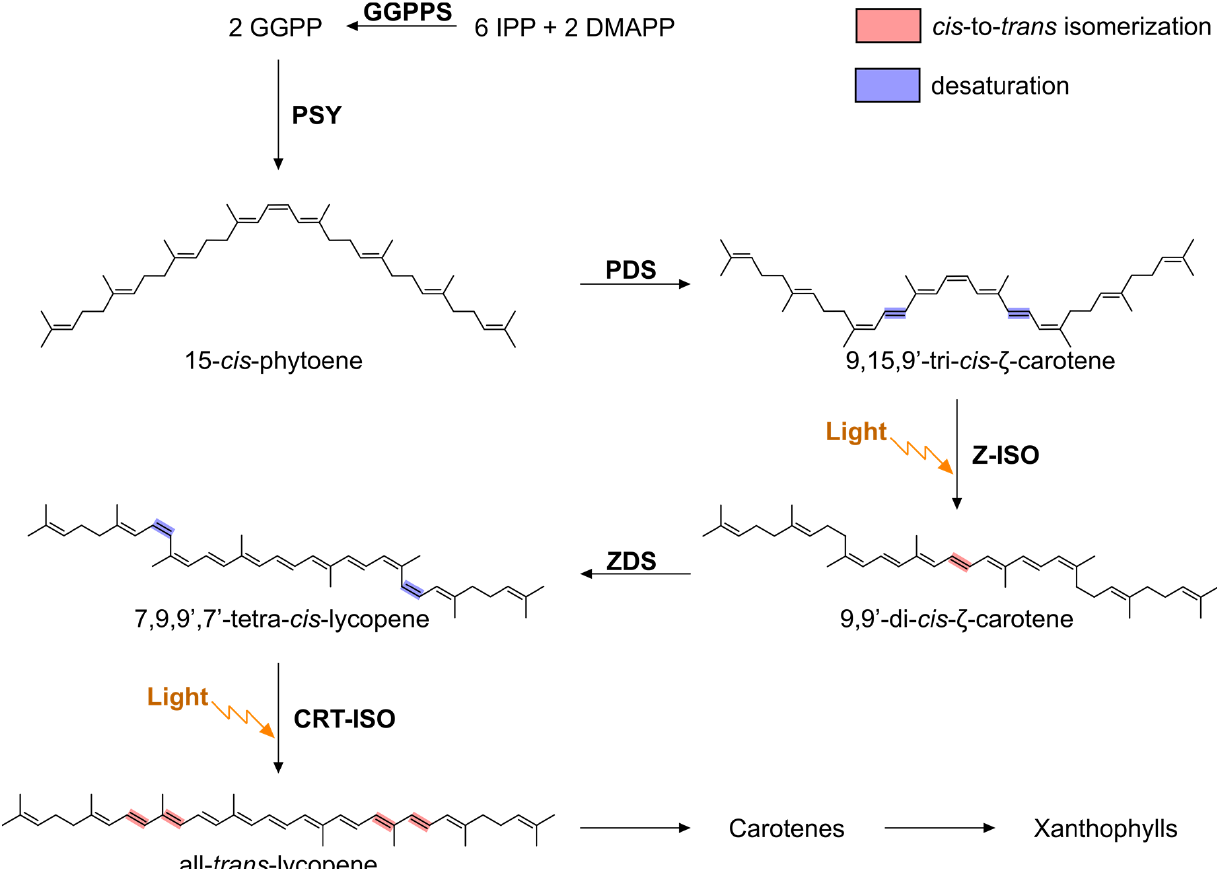
Figure 1. Overview of carotenoid biosynthesis in oxygenic phototrophs focusing on the steps in the conversion of phytoene to lycopene. The products of the MEP pathway, IPP and DMAPP, are condensed to form GGPP by the enzyme GGPP synthase (GGPPS). Two molecules of GGPP are subsequently condensed by the enzyme phytoene synthase (PSY), producing 15- cis -phytoene. Phytoene desaturase (PDS) and ζ -carotene desaturase (ZDS) introduce four double bounds by desaturation of the carotenoid backbone (blue highlight) to produce all- trans -lycopene, with cis - to- trans isomerization of bonds in the intermediate species (red highlight) carried out by Z-ISO and CRT-ISO; these cis -bonds are photo-labile and can be isomerized non-enzymatically by light (indicated by orange arrows). Subsequent modification of all- trans -lycopene (enzymatic steps not shown) yields the carotene and xanthophyll species used for light harvesting, photoprotection, and structural stabilization of proteins and lipid